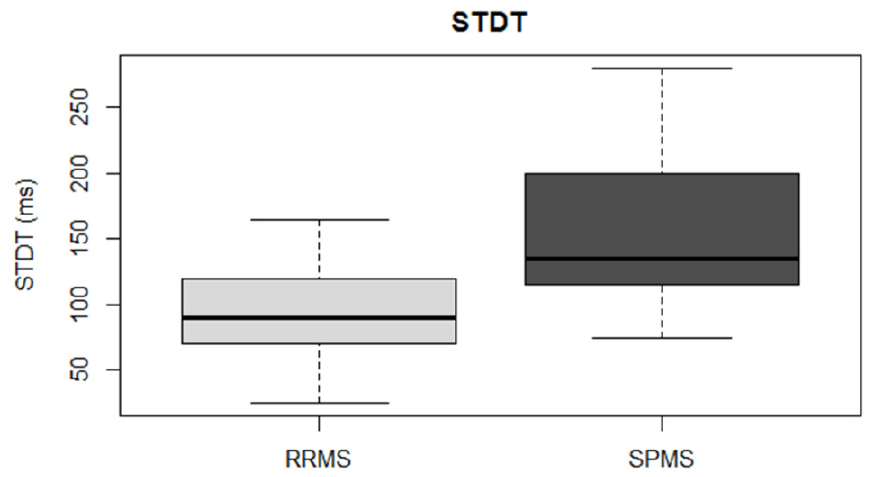
Figure 3. Somatosensory temporal discrimination threshold. SPMS showed significantly higher STDT values than RRMS. ROC curve was used to test the sensitivity and specificity of SICI and STDT separately. For SICI, the evaluation metrics were: area under the curve (AUC), 0.65; sensitivity, 0.588; and specificity, 0.679. For STDT, the evaluation metrics were: AUC, 0.805; sensitivity, 0.944; and specificity,